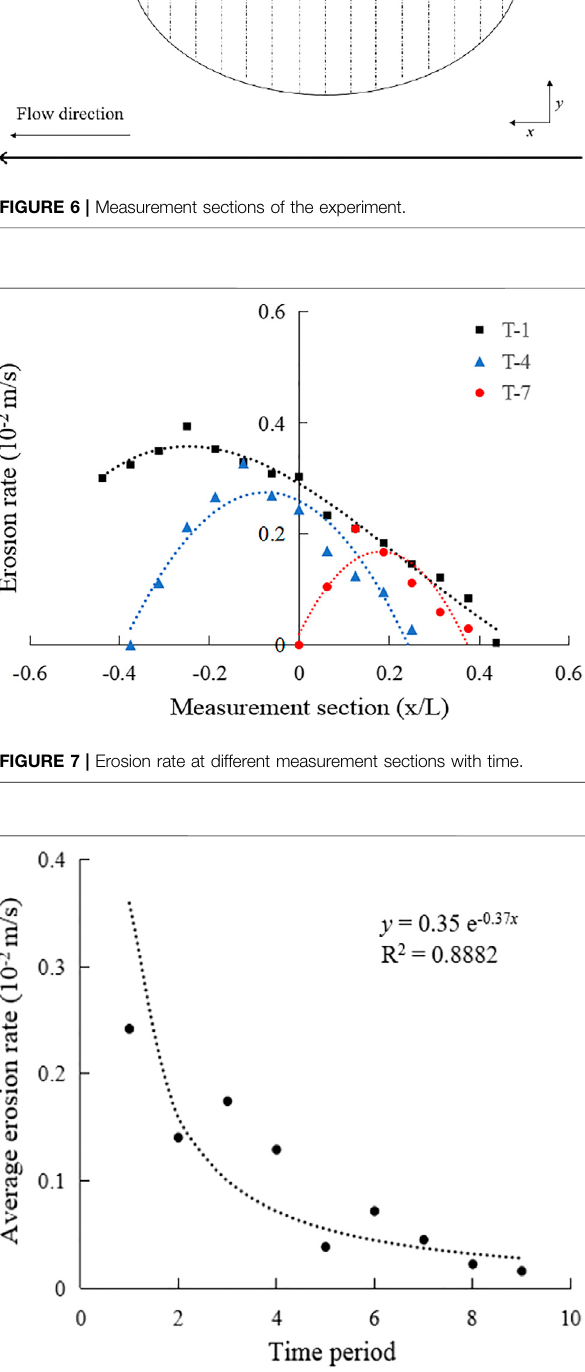
Frontiers in Earth Science |